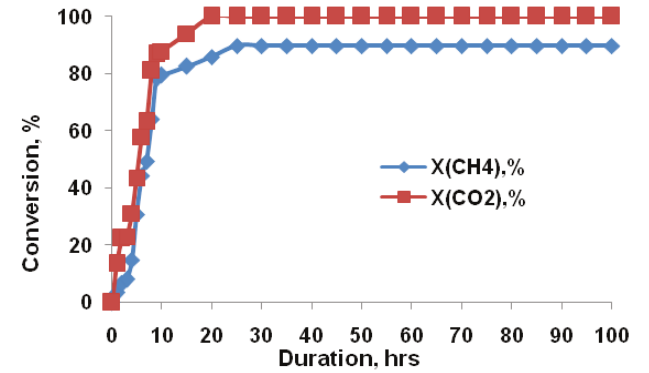
Figure 5. Dependence of biogas conversion on the duration of the experiment over the 5%Co-M GHSV=1000 h -1 , P=1 atm, T=725 o C (temperature was increased from 25 to 725 o C for the first 20 hours and then was kept